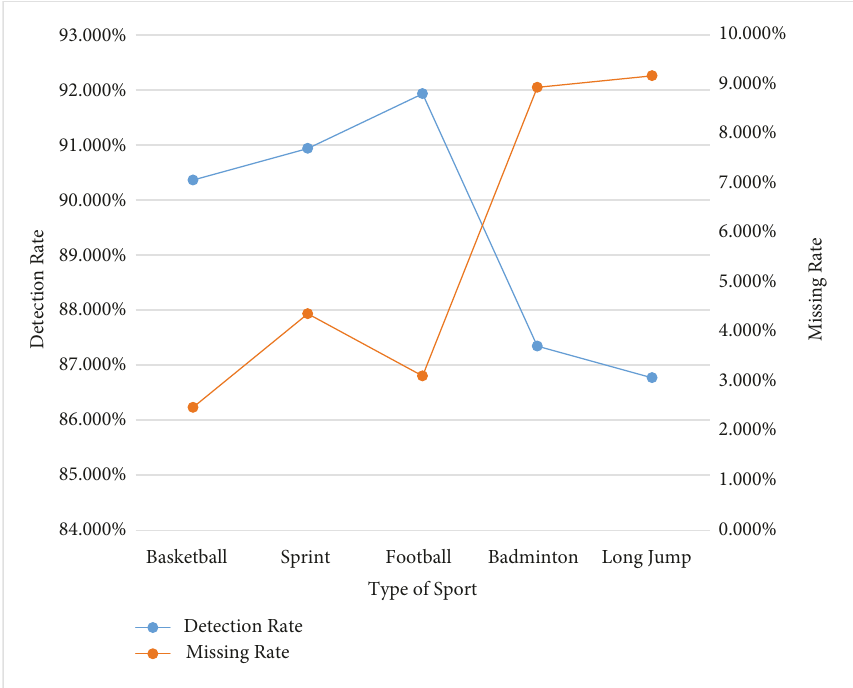
Figure 7: Line figure of detection rate and missed detection rate of different sports